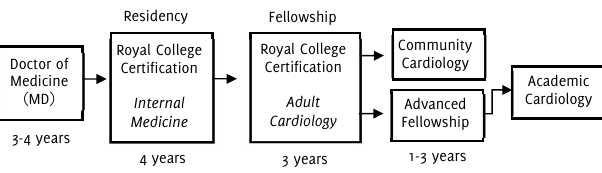
Figure 1 . Training path to becoming a cardiologist in